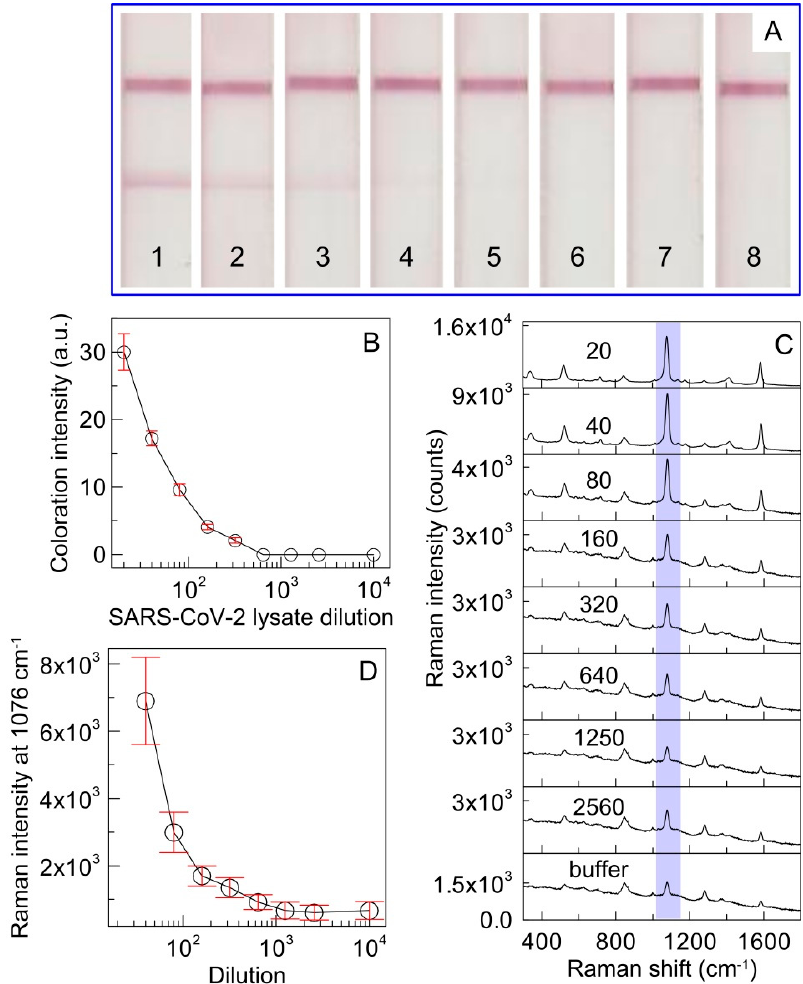
Figure 5. ( A ) Photographic images of LFIA strips after application of the lysate at sequential two-fold dilutions of 20 (1), 40 (2), 80 (3), 160 (4), 320 (5), 640 (6), 1280 (7), and 2560 (8); ( B ) Calibration curve obtained after conventional LFIA procedure using SERS nanotags as immunoprobe for spike RBD detection in SARS-CoV-2 viral lysate. The error bars indicate the STD for three measurements; ( C ) SERS spectra measured in the TZ for different lysate dilutions. The numbers mean the dilution. ( D ) Dependence of the SERS intensity on the lysate dilution. The bars show the STD of the Raman signal at 1076 cm − 1 , measured at five points in the middle of the test line.